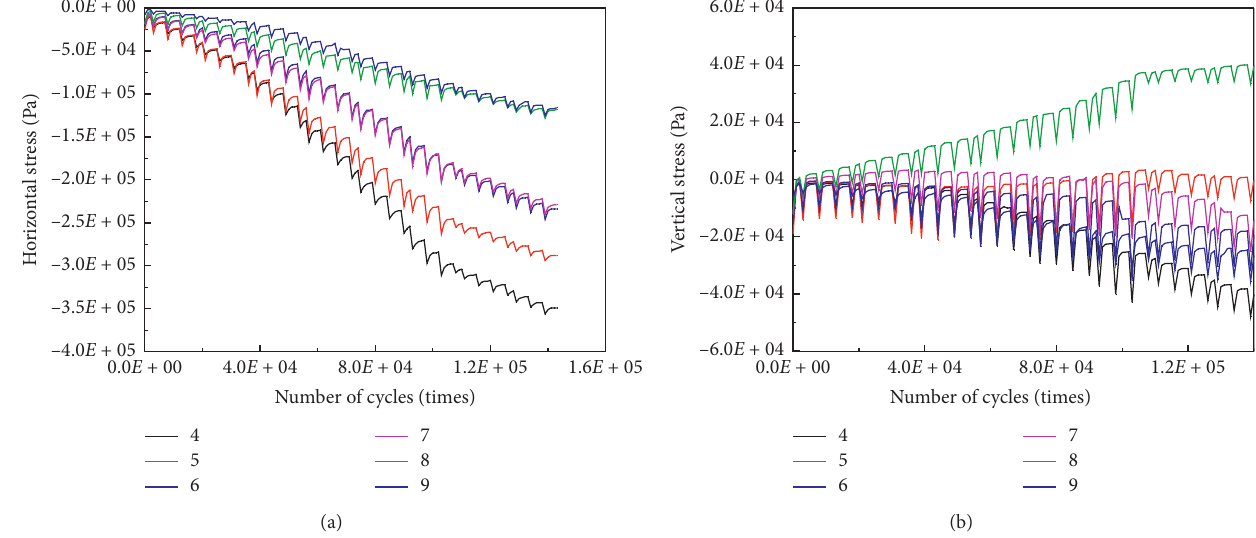
Figure 11: Stress of the slope top. (a) Horizontal. (b) Vertical.